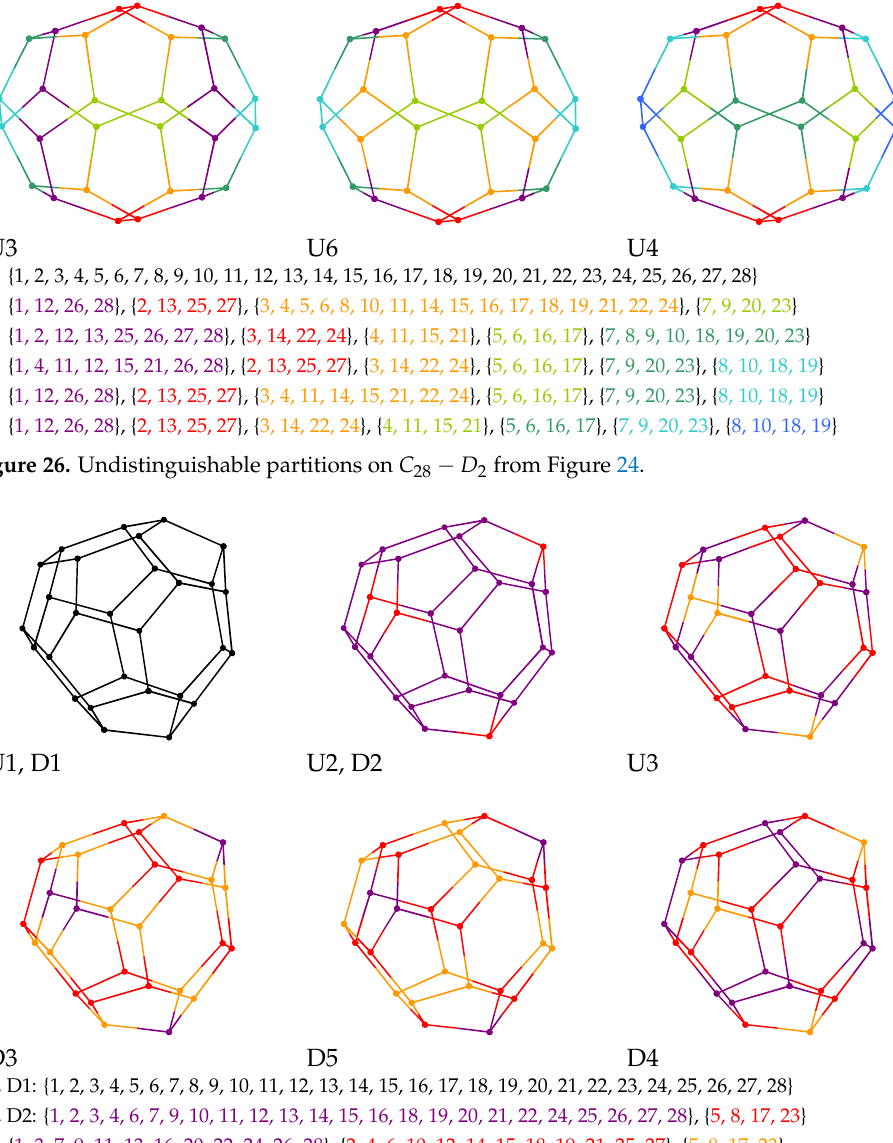
Figure 27. Partitions on C 28 − T d from Figure 24. Regarding the pairing (U2, D2) appearing for C 28 − T d (Figure 27), this pairing does not appear for C 28 − D 2 (Figure 25 vs. Figure 26) suggesting that its occurrence is again due to the increased symmetry of C 28 − T d than C 28 − D 2